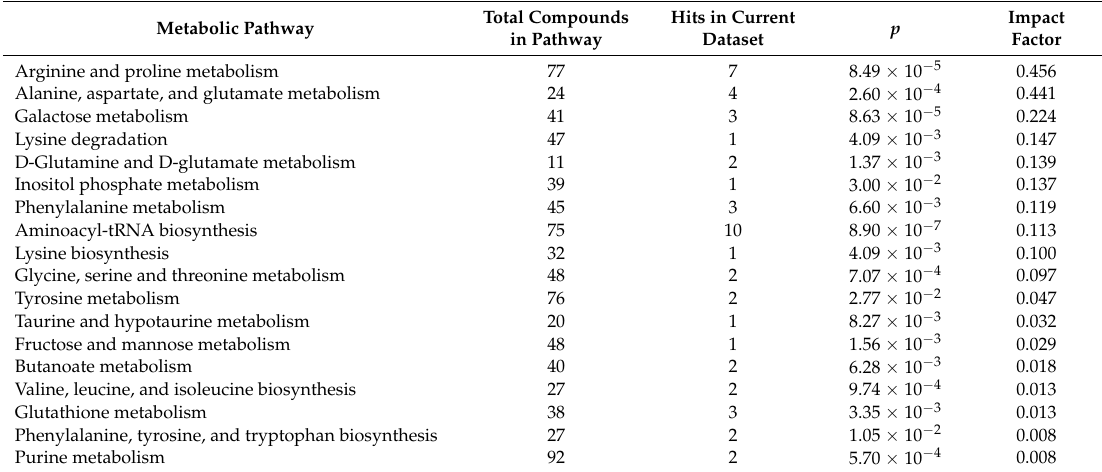
Table 4. Topological metabolic pathway